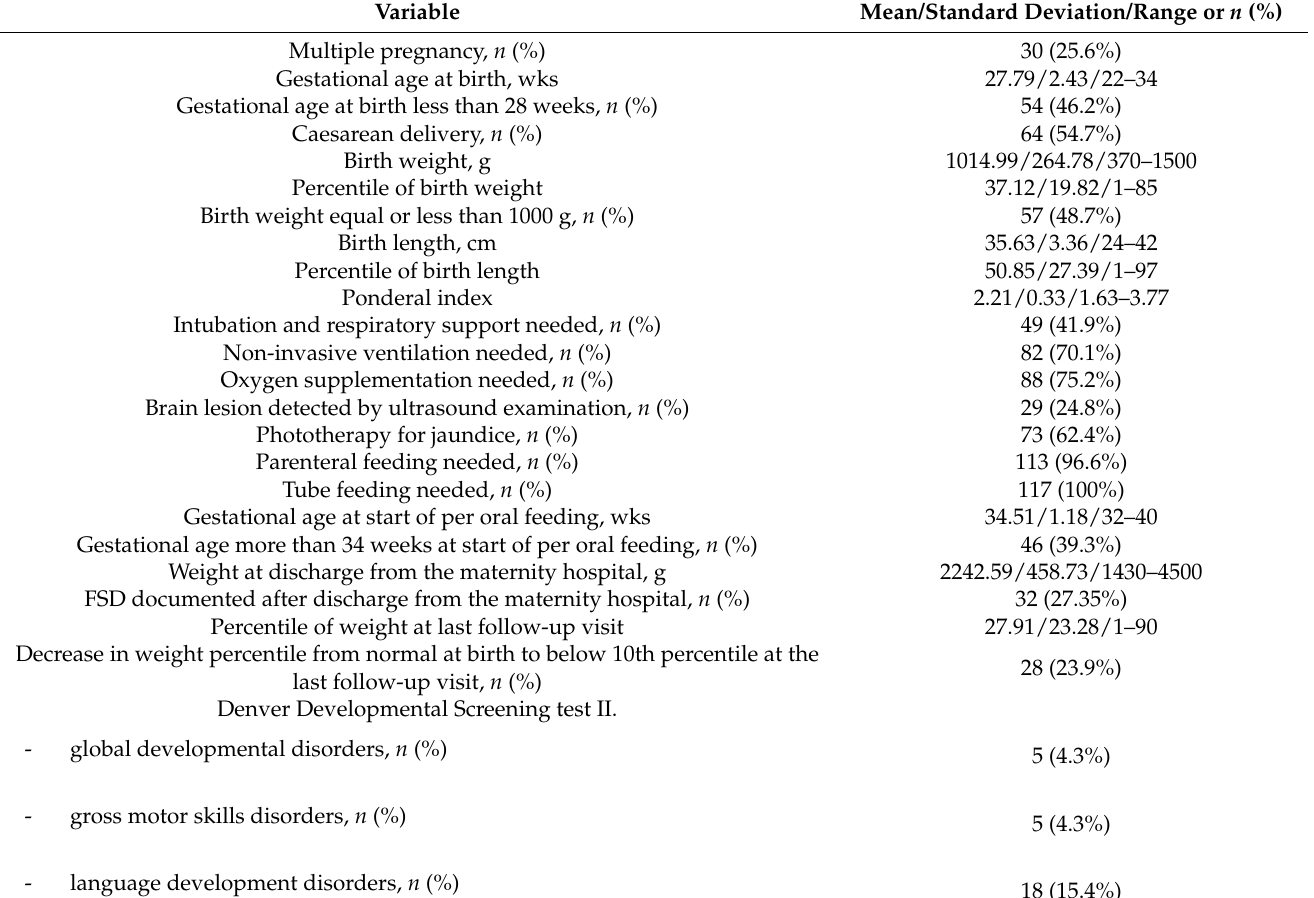
Table 1. Descriptive statistics for data from the medical documentation of the Ljubljana Maternity Hospital (before discharge and at follow-up visits) ( n =